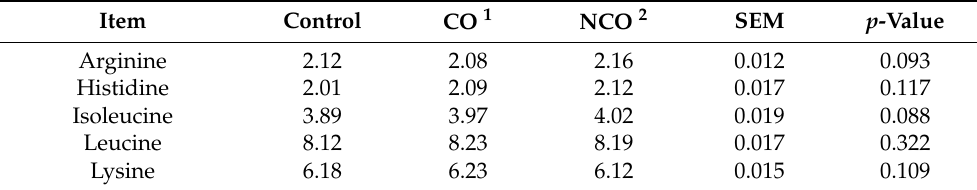
Table 5. The effect of the supplementation of raw and nanoemulsified corn oil on the amino acid composition in the milk of dairy